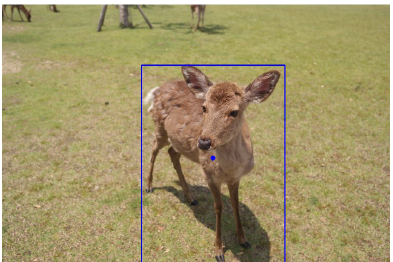
Figure 8. The main body of the foreground and the center of the